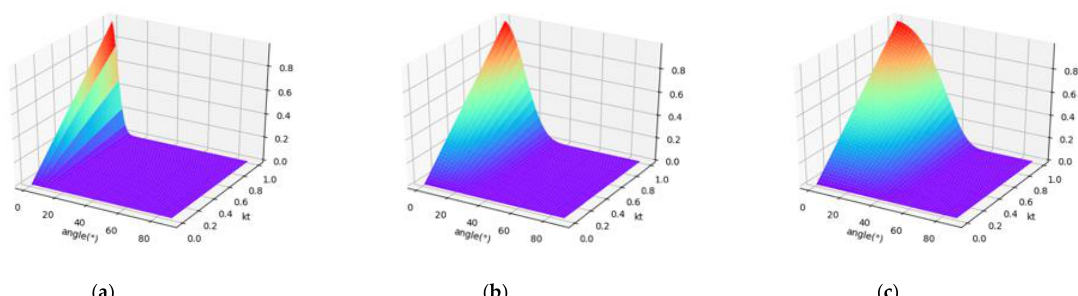
Figure 2. The variation of the specular reflection intensity, I ( θ , λ ) , with the incident angle, θ , and k d ( λ ) . Parameter m is fixed at 0.1, 0.3, and 0.5, respectively. ( a ) m = 0.1; ( b ) m = 0.3; ( c ) m = 0.5.